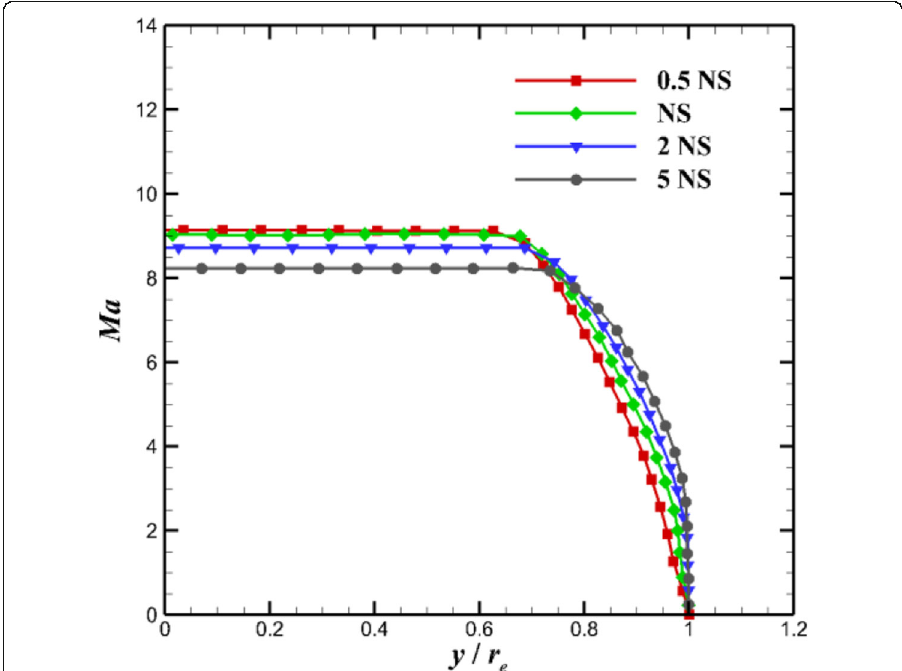
Fig. 12 Comparison of the exit Mach number distribution based on the HEG